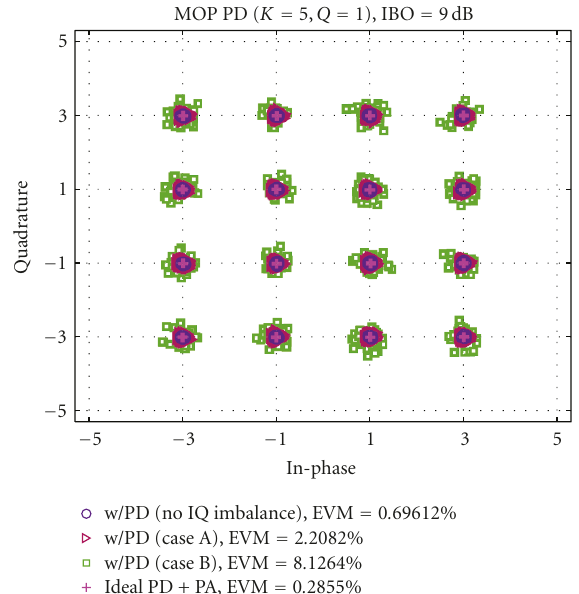
Figure 7: Normalized PSD and the corresponding ACPR value of the simulated input and output of the linearized PA with and without IQ imbalance.